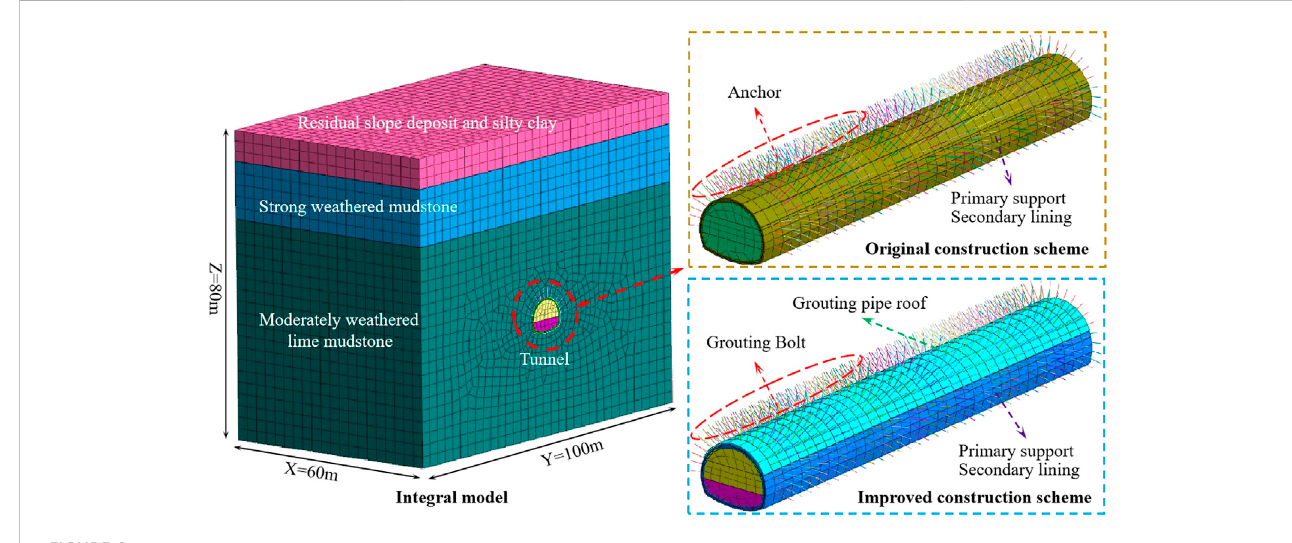
FIGURE 8 Three-dimensional fi nite element model.